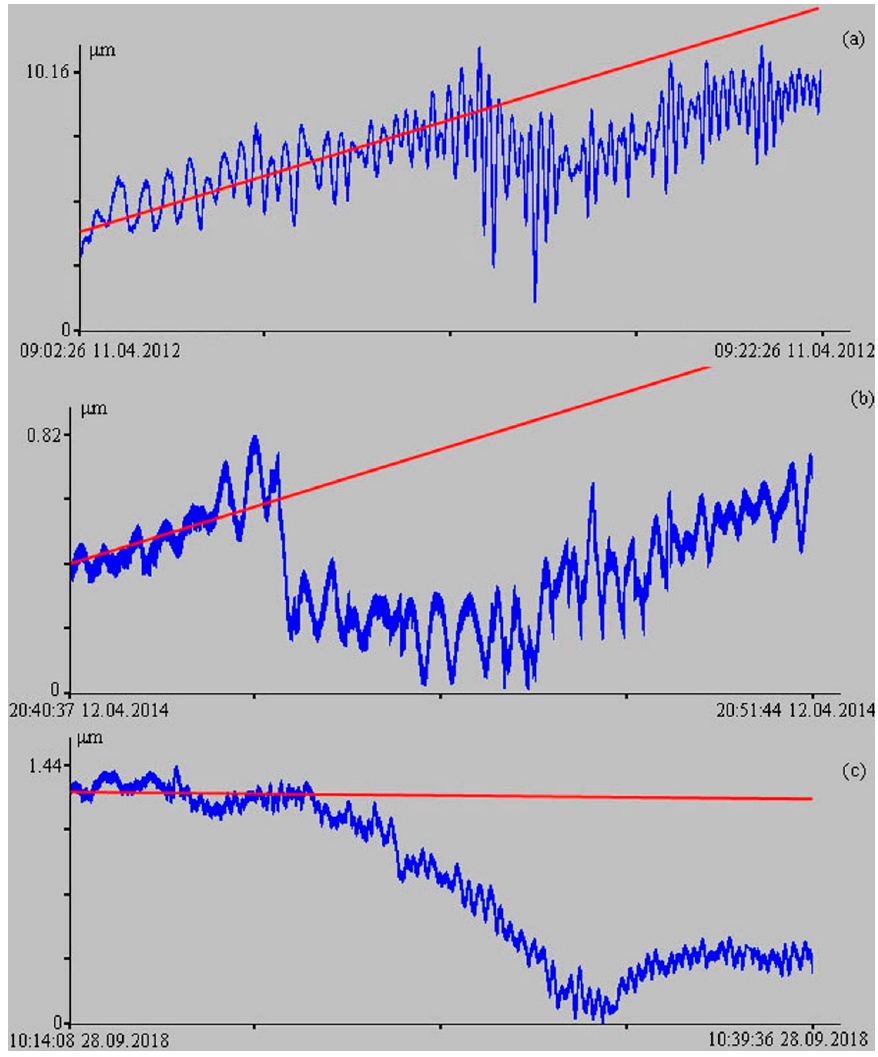
Figure 5. Fragments of 52.5 m laser strainmeter recordings from April 2012 ( a ), April 2014 ( b ), and September 2018 ( c ).